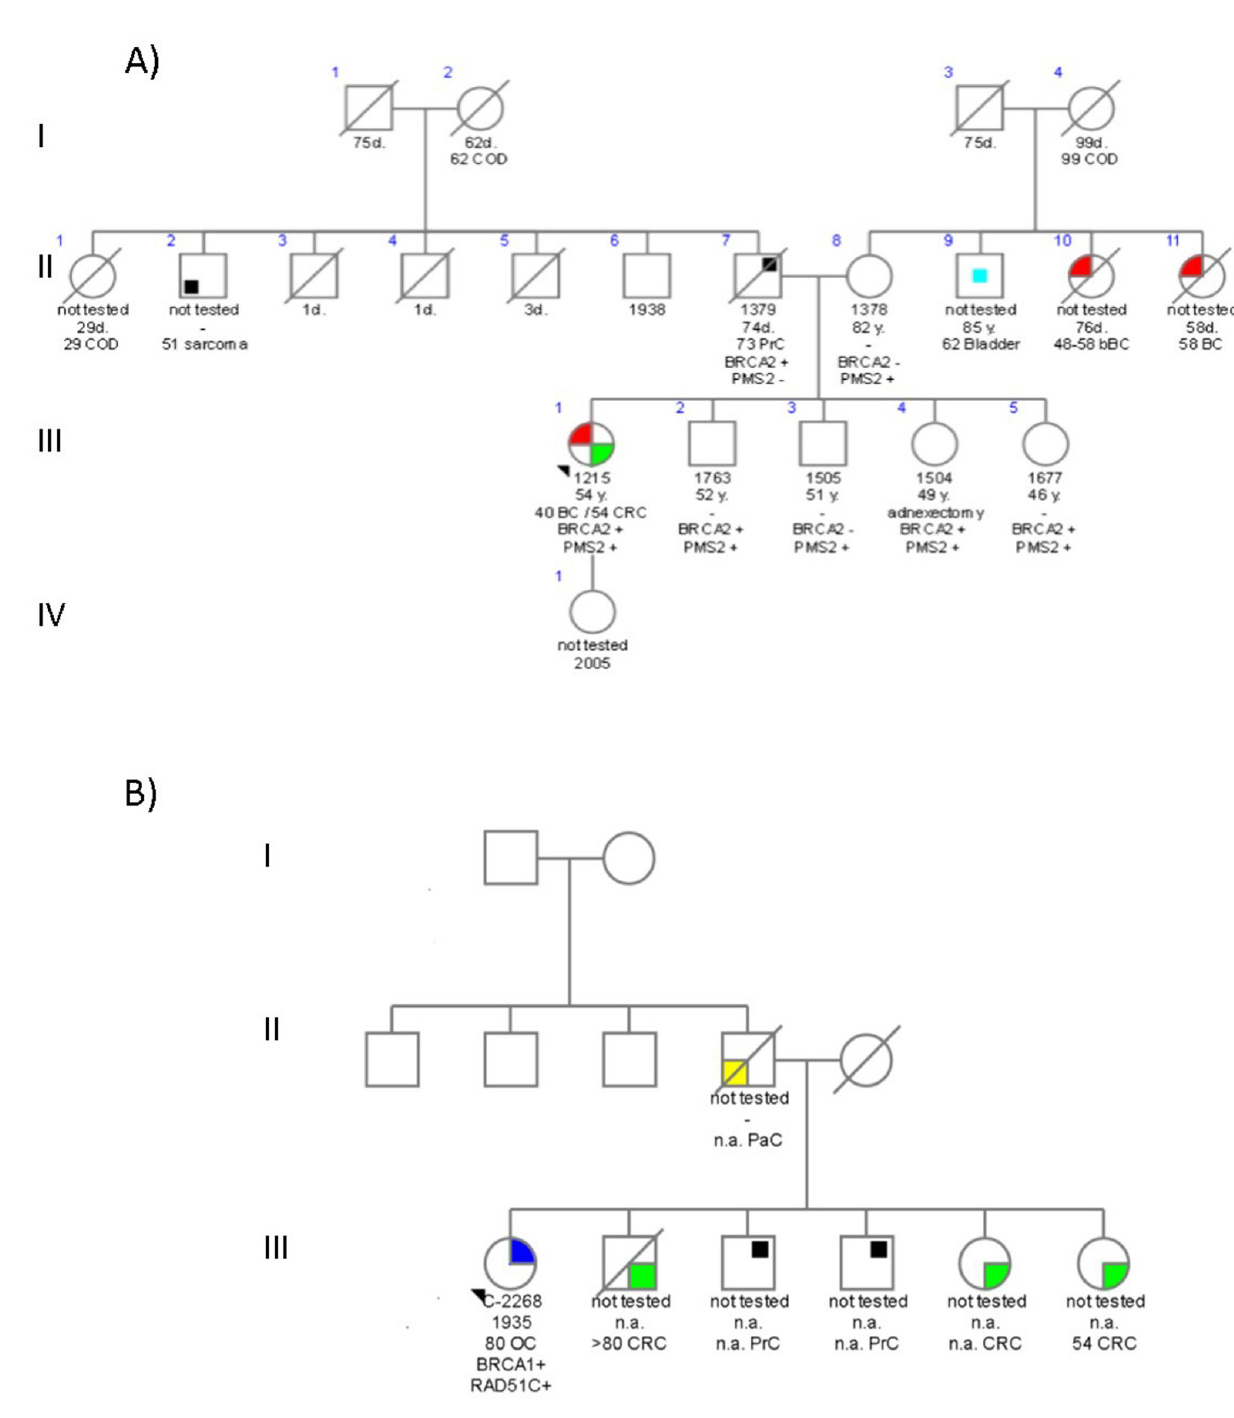
Figure 2. Pedigrees of double heterozygote BRCA1/RAD51C and BRCA2/PMS2 families. ( A ) Family with c.5146_5149delTATG (p.Tyr1716Lysfs*8) in BRCA2 and c.903G>T (p.Lys301Asn) in PMS2 ; ( B ) Family with c.4165_4166delAG (p.Gln1388_Ser1389ins*) in BRCA1 and c.709C>T (p.Arg237*) in RAD51C. Index cases are indicated by an arrow. Confirmed mutation carriers are indicated by a “+” sign, and non-carriers are indicated by a “-” sign. Age at diagnosis and cancer type is specified as follows: BC, breast cancer; bBC, bilateral breast cancer; OC, ovarian cancer; CRC, colorectal cancer; PrC, prostate cancer; PaC, pancreas cancer; n.a., not available. The colors stand for each type of cancer as follows: red stands for BC, blue stands for OC, green stands for CRC, yellow stands for Gastric Cancer, black stands for another type of